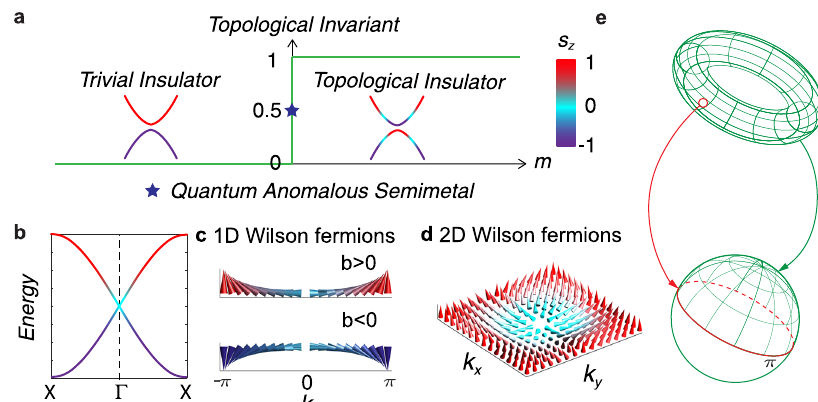
Fig. 1 Quantum anomalous semimetal. a The phase diagram and topological invariant of trivial insulator, quantum anomalous semimetal and topological insulator. b The dispersion of the Wilson fermions along the wave vector k x and keeping all other k i = 0. c The spin texture of 1D Wilson fermions. d The spin texture of 2D Wilson fermions. e The relative homotopy group mapping of band structure and spin texture of the parity anomalous semimetal. The whole torus on the fi rst Brillouin zone maps to the semi-Bloch sphere (green line) and the small loop around crossing point to the equator of the Bloch sphere (red